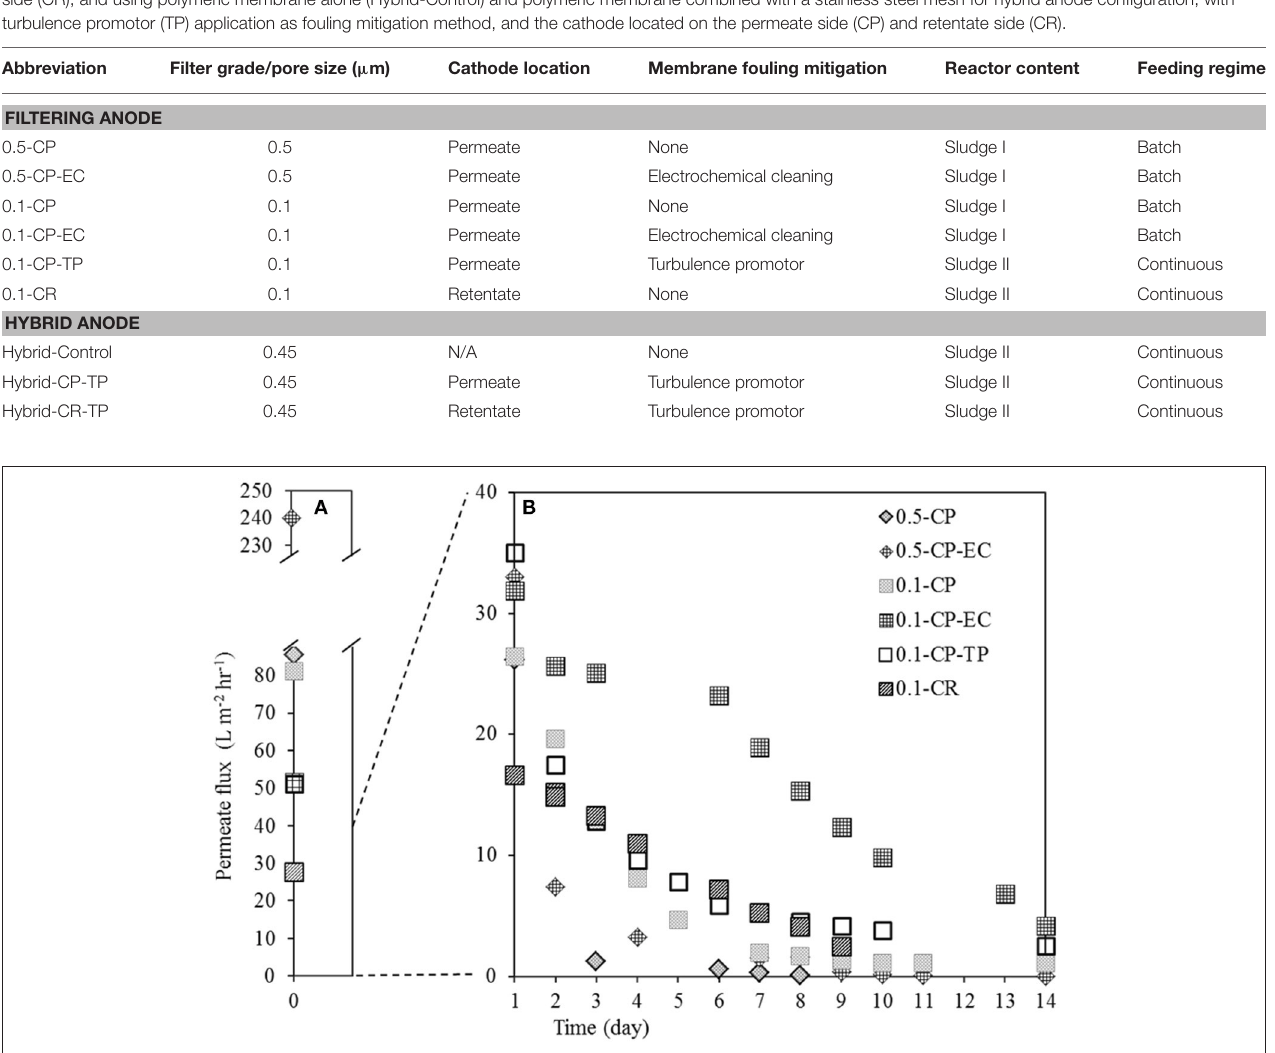
FIGURE 3 | Permeate fluxes on (A) Day 0 and (B) Day 1-14 as a result of operating BES integrated with AnMBR with crossflow filtration using filtering anode of filter grade 0.1 and 0.5 µ m stainless steel membranes; with electrochemical cleaning (EC) and turbulence promotor (TP) application as fouling mitigations methods, and the cathode located on the permeate side (CP) and retentate side